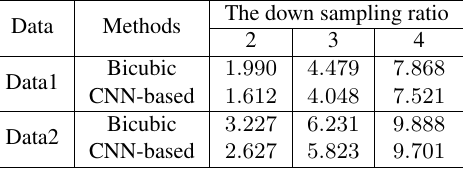
Table 1. The mean square error of reconstructions